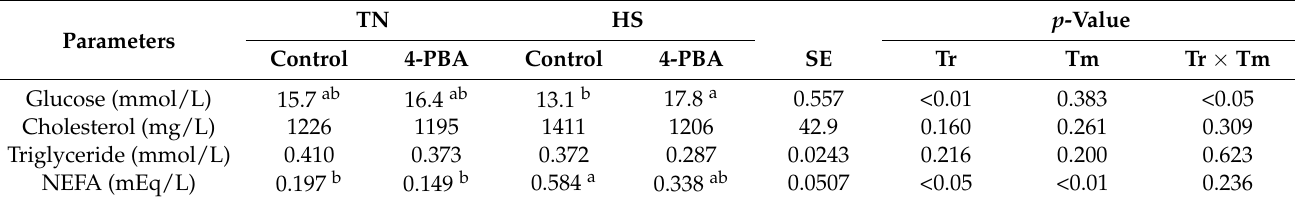
Figure 2. Effects of 4-PBA on the cloacal temperature in the heat-stressed broiler chickens. The cloacal temperature of broiler chickens fed control or 4-PBA supplementation in diet before and after heat exposure for 2 h. Data show means ± SE ( n = 6–7). The presence of different letters indicates statistical significance. Tr: treatment; Tm: temperature. Table 4. Blood parameters of broiler